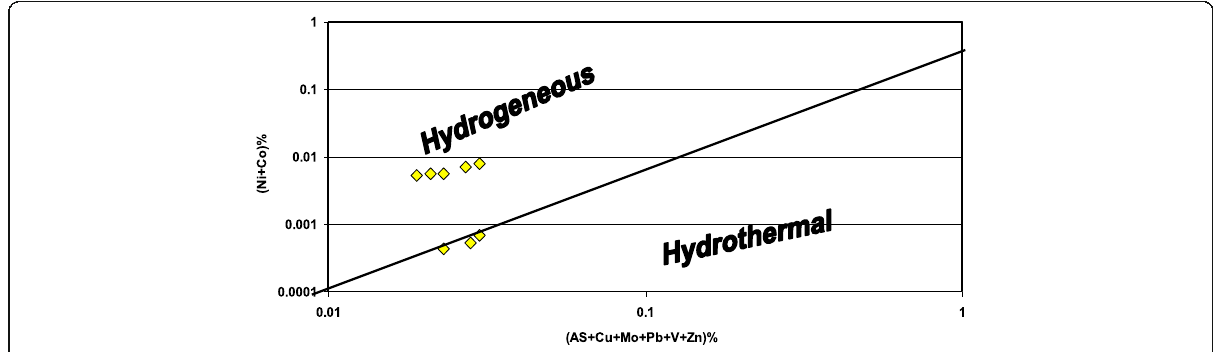
Fig. 6 (Ni + Co) versus (As + Cu + Mo + V + Zn) plot diagram after Nicholson (19